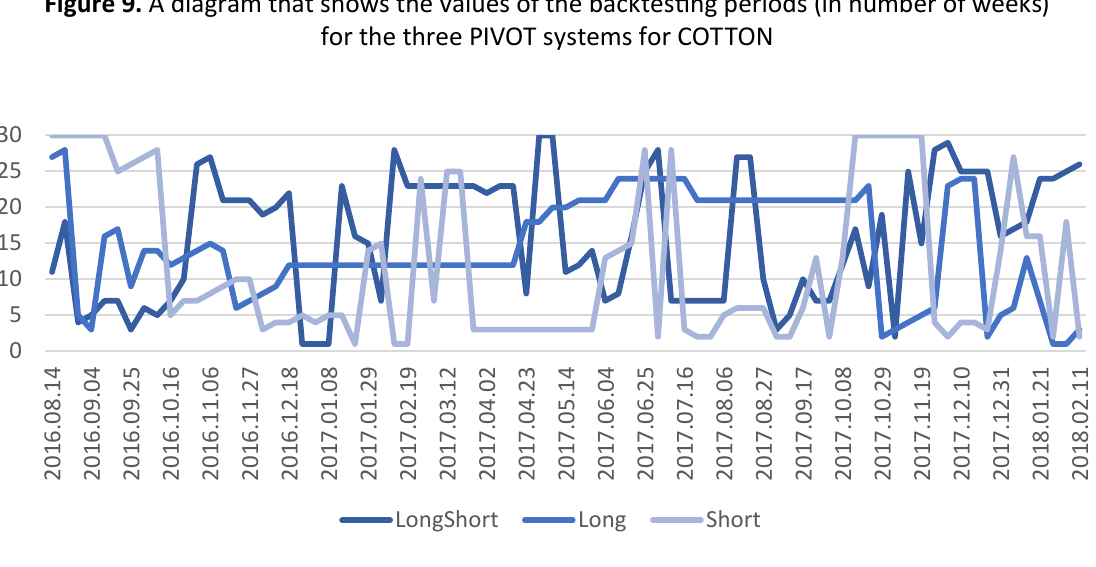
Figure 10. A diagram that shows the values of the backtesting periods (in number of weeks) for the three PIVOT systems for NATGAS